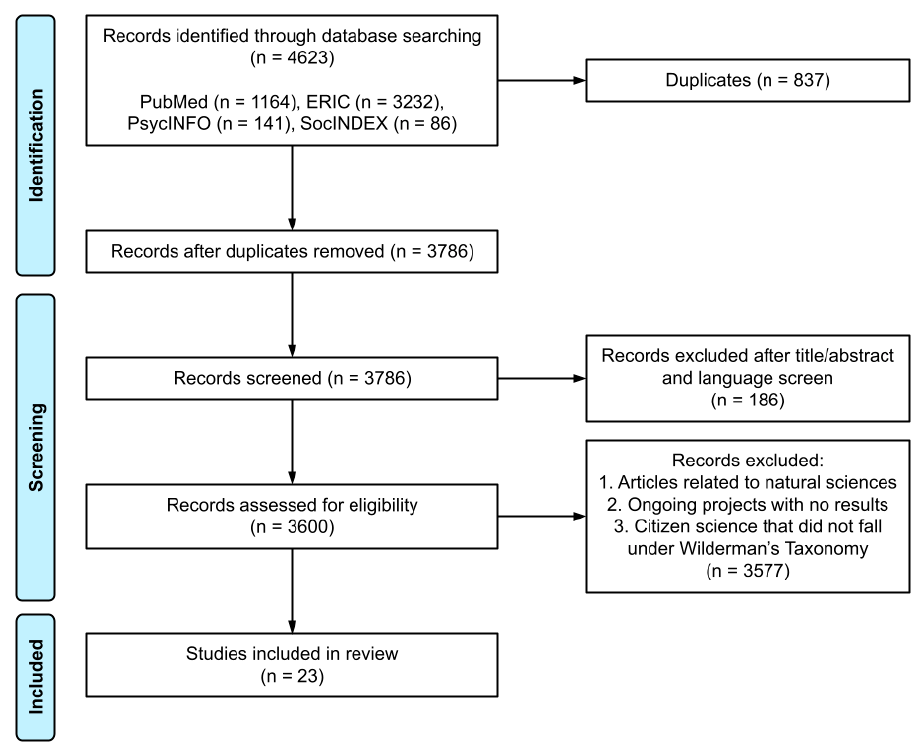
Figure 1. Flowchart of the selection process according to PRISMA.